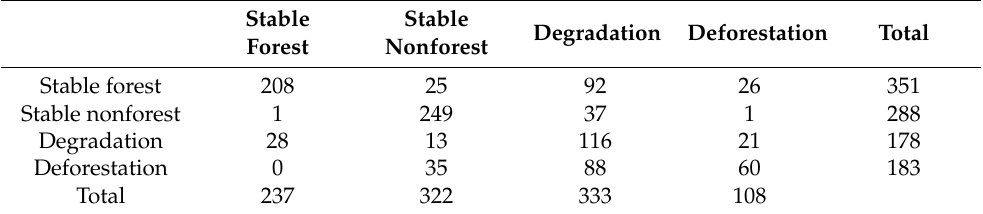
Table 2. Error matrix with sample counts for the Map 11 iteration. Each grid cell is the correspondence between the final map (rows) and the reference data (columns). Note that the row (map values) totals do not correspond to the 250 samples originally derived from each class because the map is different from the stratification used to create the sample (see Section